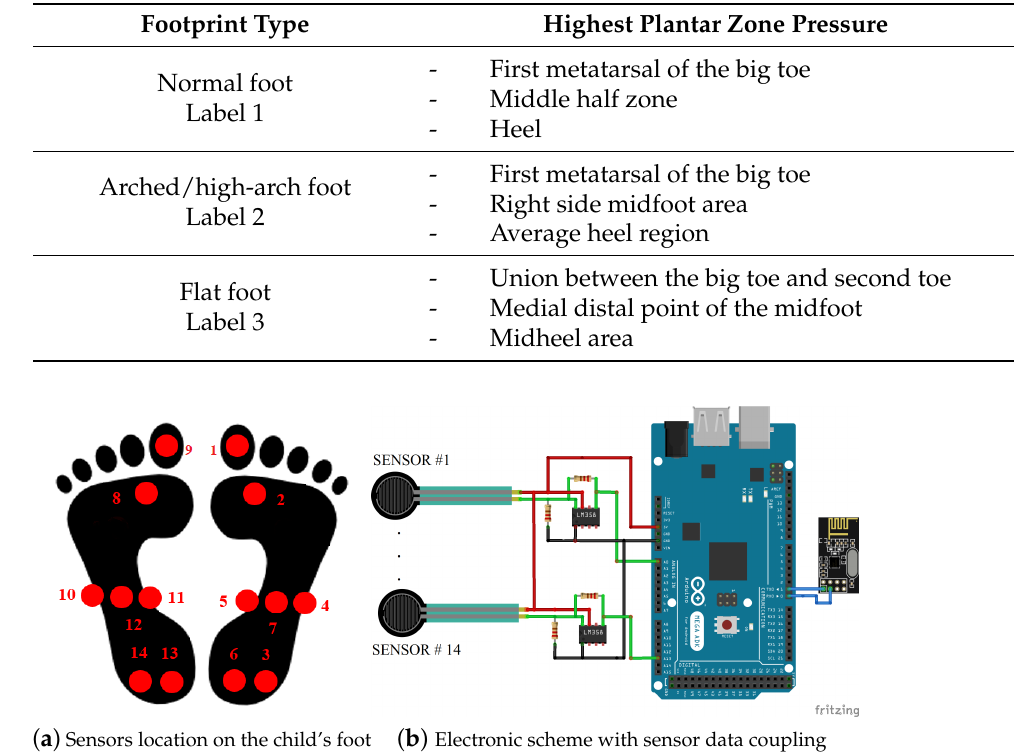
Figure 2. The proposed data acquisition